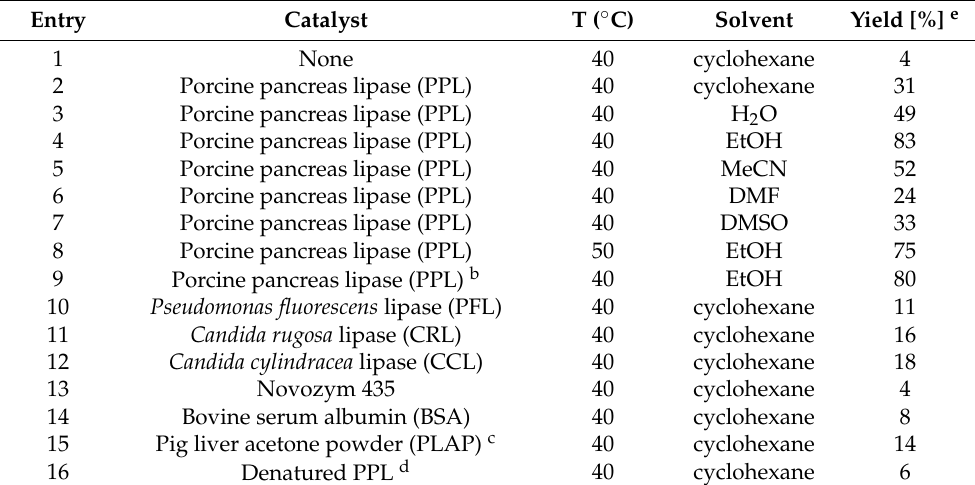
Table 2. The MCR toward 5a , catalyzed by different enzymes [a]